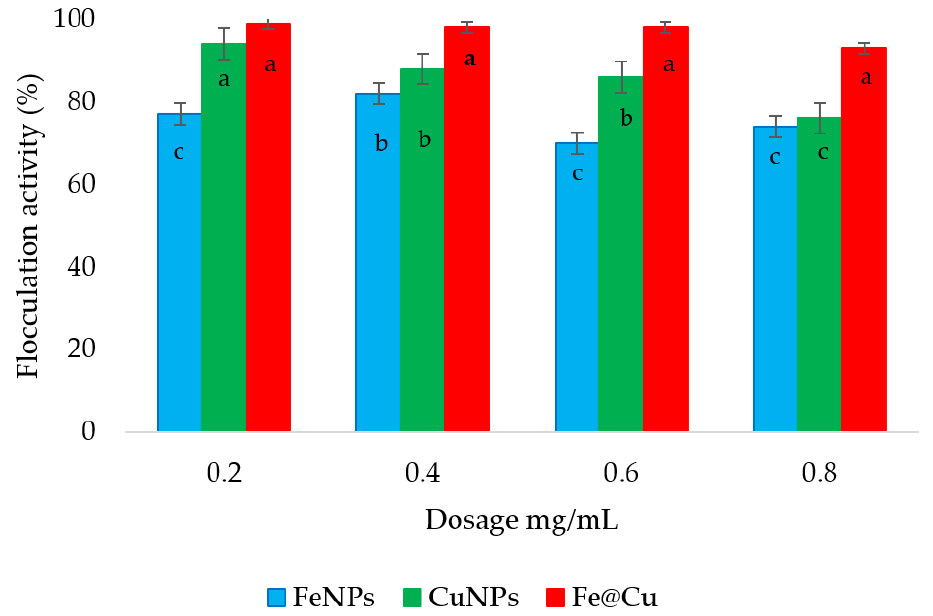
Figure 1. Effect of nanoparticles dosage concentration on the flocculation activity at room temperature different letters (a, b and c) denotes statistical significance at ( p < 0.05).